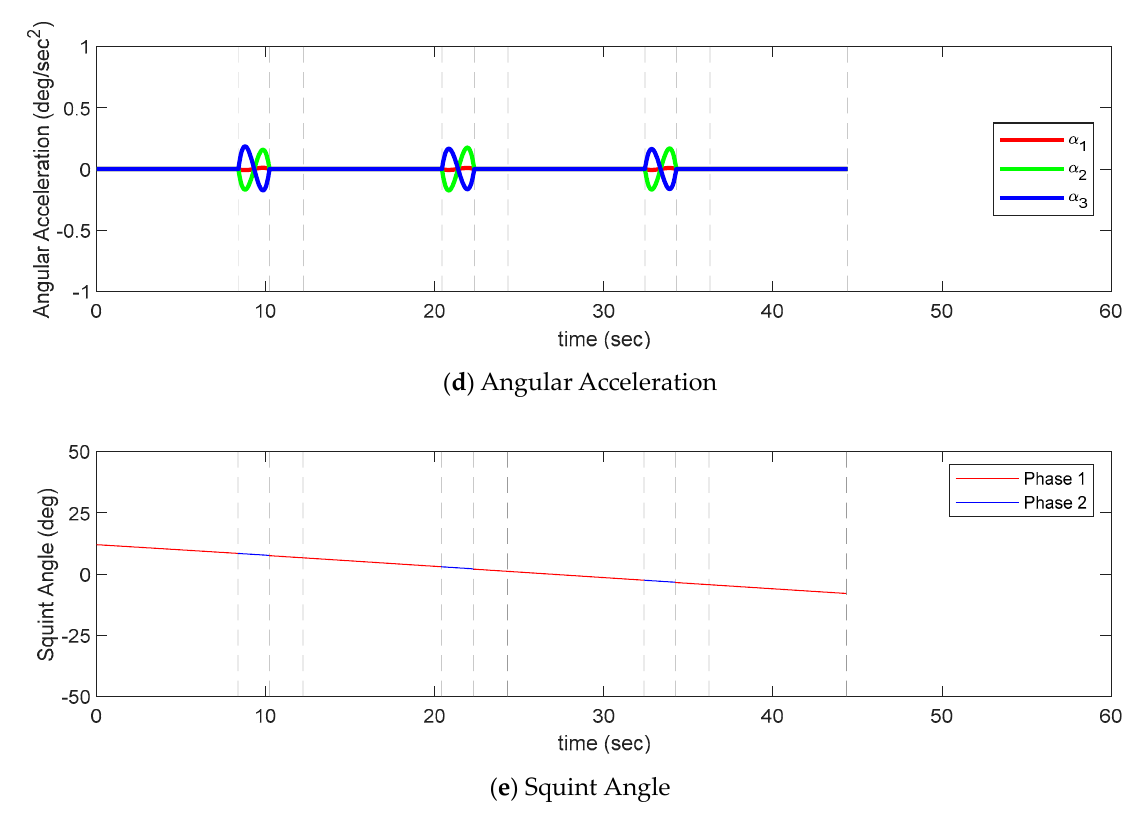
Figure 20. Timeline/quaternion/angular velocity/angular acceleration/squint angle for Scenario 1.